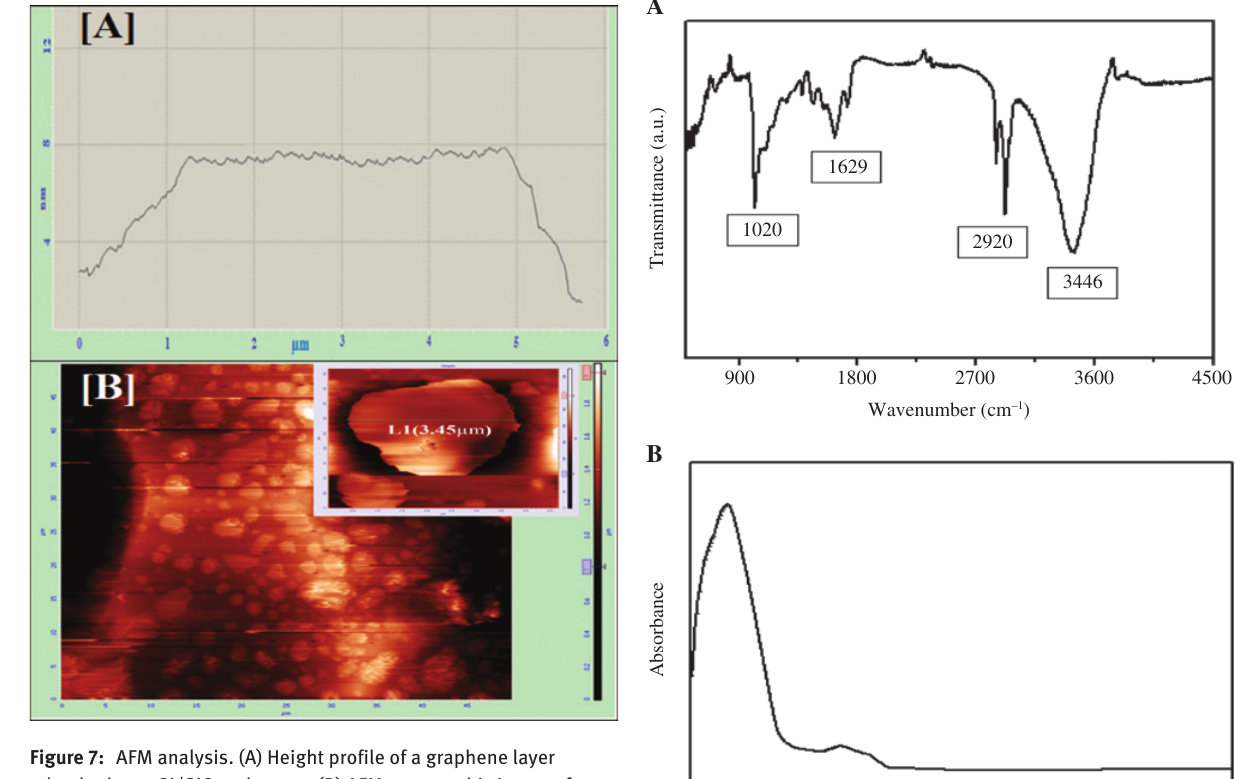
Figure 7: AFM analysis. (A) Height profile of a graphene layer adsorbed on a Si/SiO substrate. (B) AFM topographic image of 2 electrochemically exfoliated graphene. The inset (top right corner) is an enlarged image of exfoliated graphene.